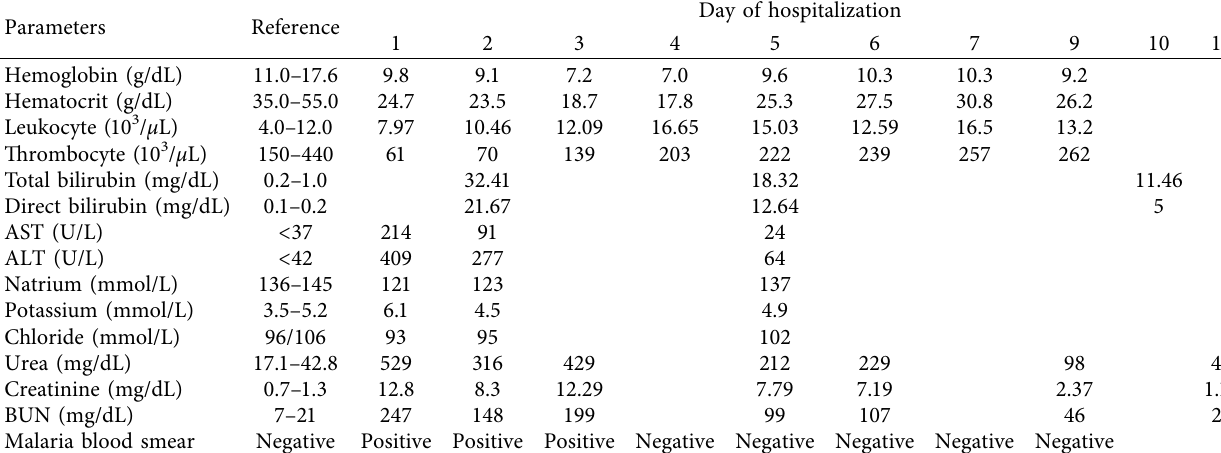
Table 1: Patient’s laboratory fndings during hospitalization.